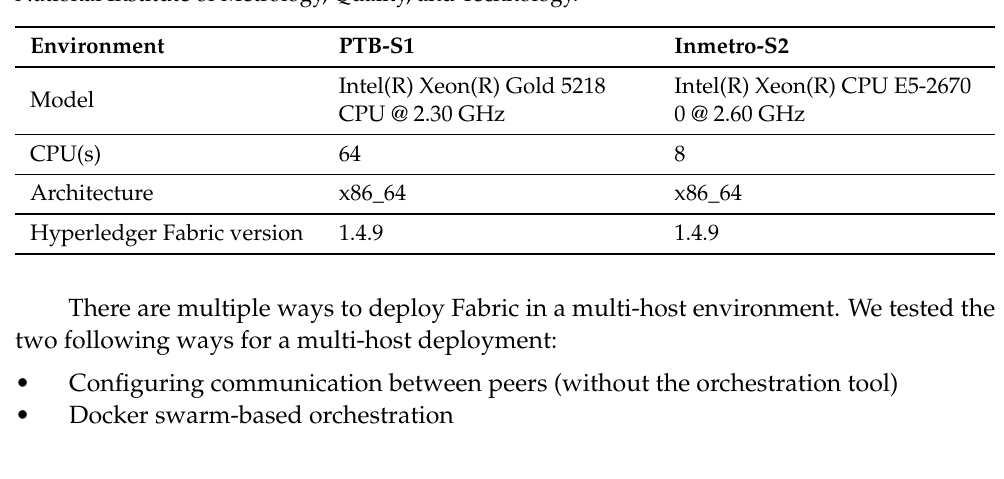
Table 1. Server configuration. PTB, Physikalisch-Technische Bundesanstalt; S1, Server 1; Inmetro, National Institute of Metrology, Quality, and